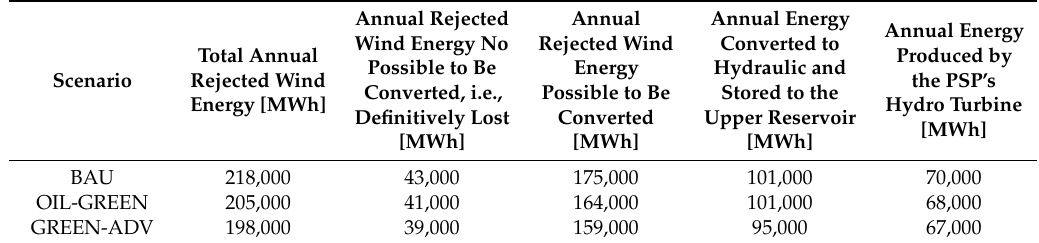
Table 5. The annual energy results of the optimal PSP for each